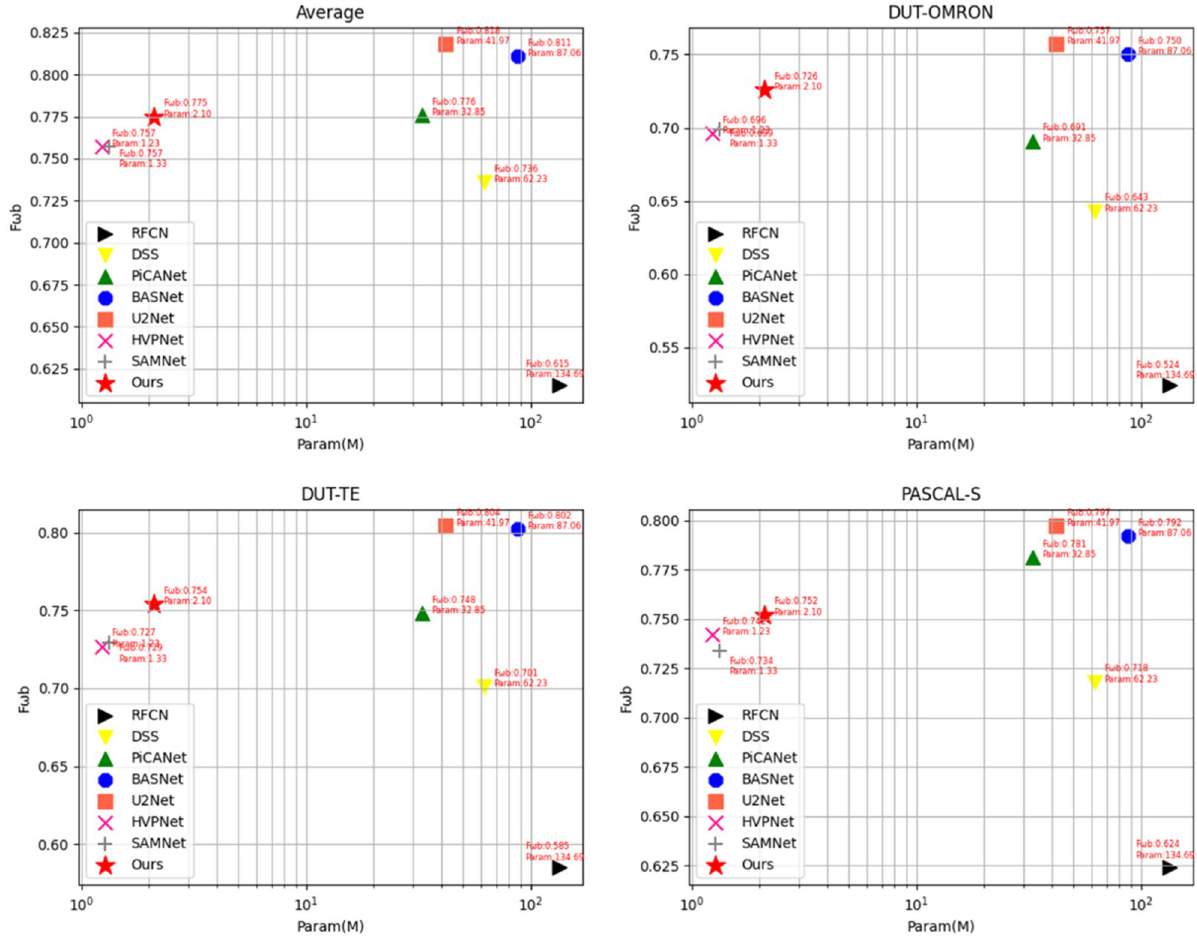
Figure 5. The number of model parameters and the metrics trade-off